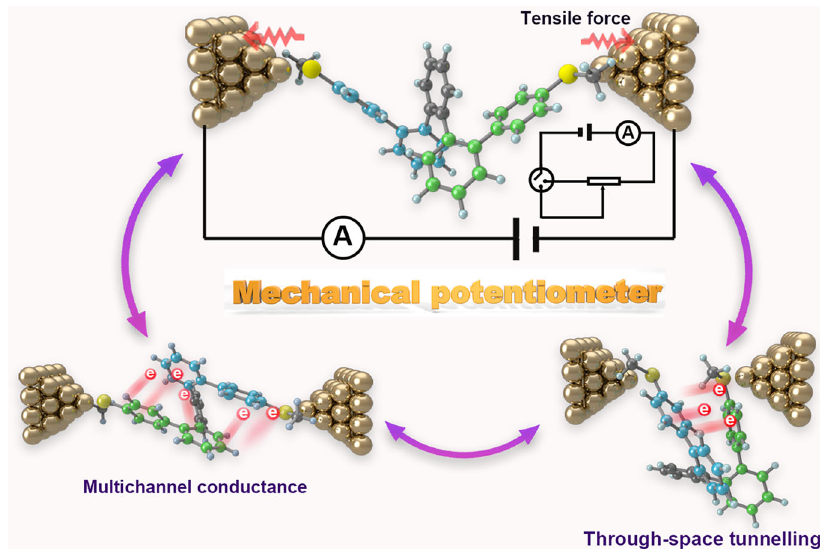
Fig. 1 Schematic illustration of a mechanical single-molecule potentiometer based on o -PP-2SMe. The tensile force originated from the movement of the Au tip can change the contact conformers of o -PP-2SMe then change the conductance of o -PP-2SMe aiming to control the circuit current. The change of conformers also leads to the alteration of the charge transport mechanism. The inset is the circuit diagram containing the